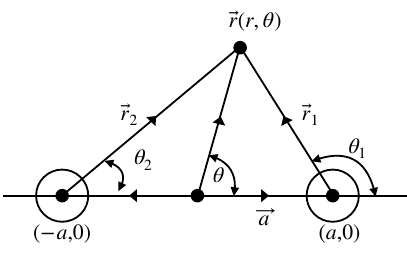
Figure 5 . Configuration of two strings. The right (left) strings are placed at ( a, 0) [ ( − a, 0) ]. ( r, θ ) are polar coordinates from the origin, and ( r 1 , θ 1 ) [ ( r 2 , θ 2 ) ] are polar coordinates from ( a, 0) [ ( − a, 0)